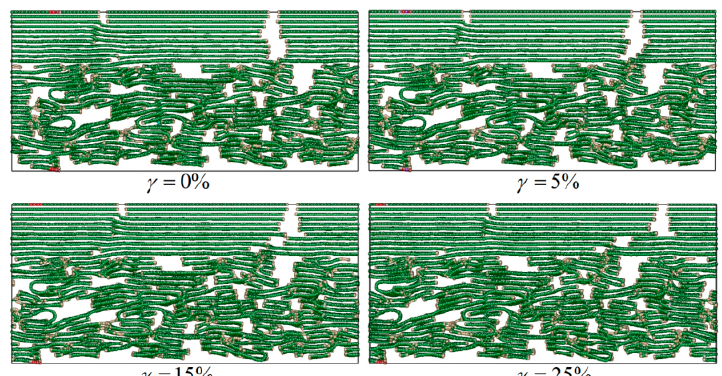
Figure 13. Typical failure modes of the C f /PyC interphase under a tangential shear load when L a = 10 nm.